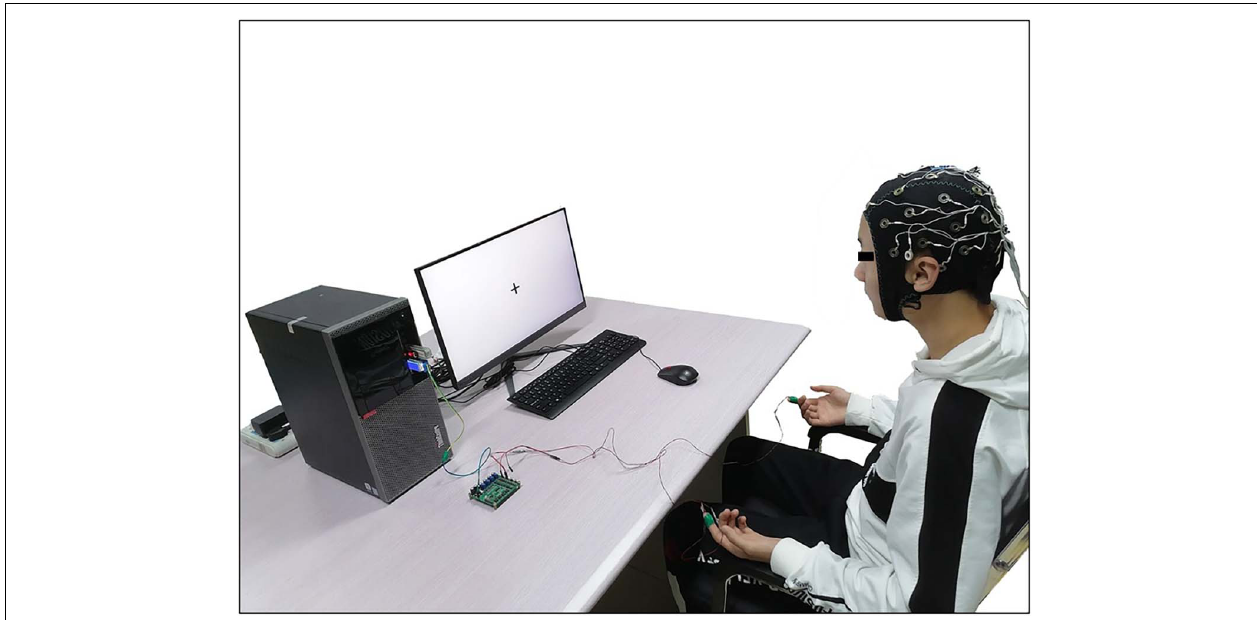
FIGURE 2 | The test process: Each subject was asked to sit in a chair during the test in a relaxed condition, with their hands being rested on armrests. During the test, the subject should gaze fixedly at the “+” (symbol) on the screen.